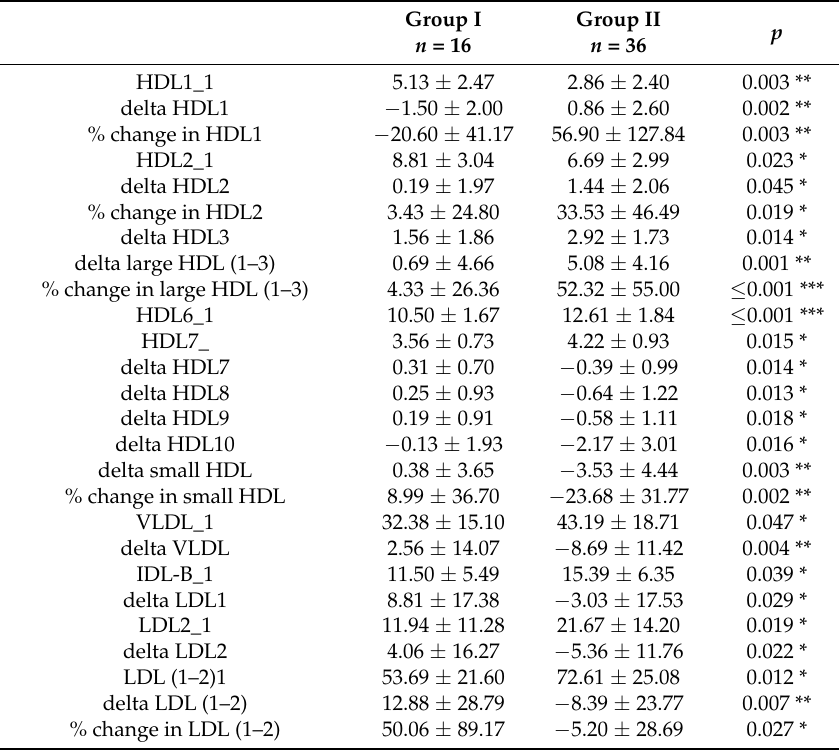
Table 5. Average values of statistically significant HDL-C and LDL-C sub-fractions in study groups, categorized according to the new AIP